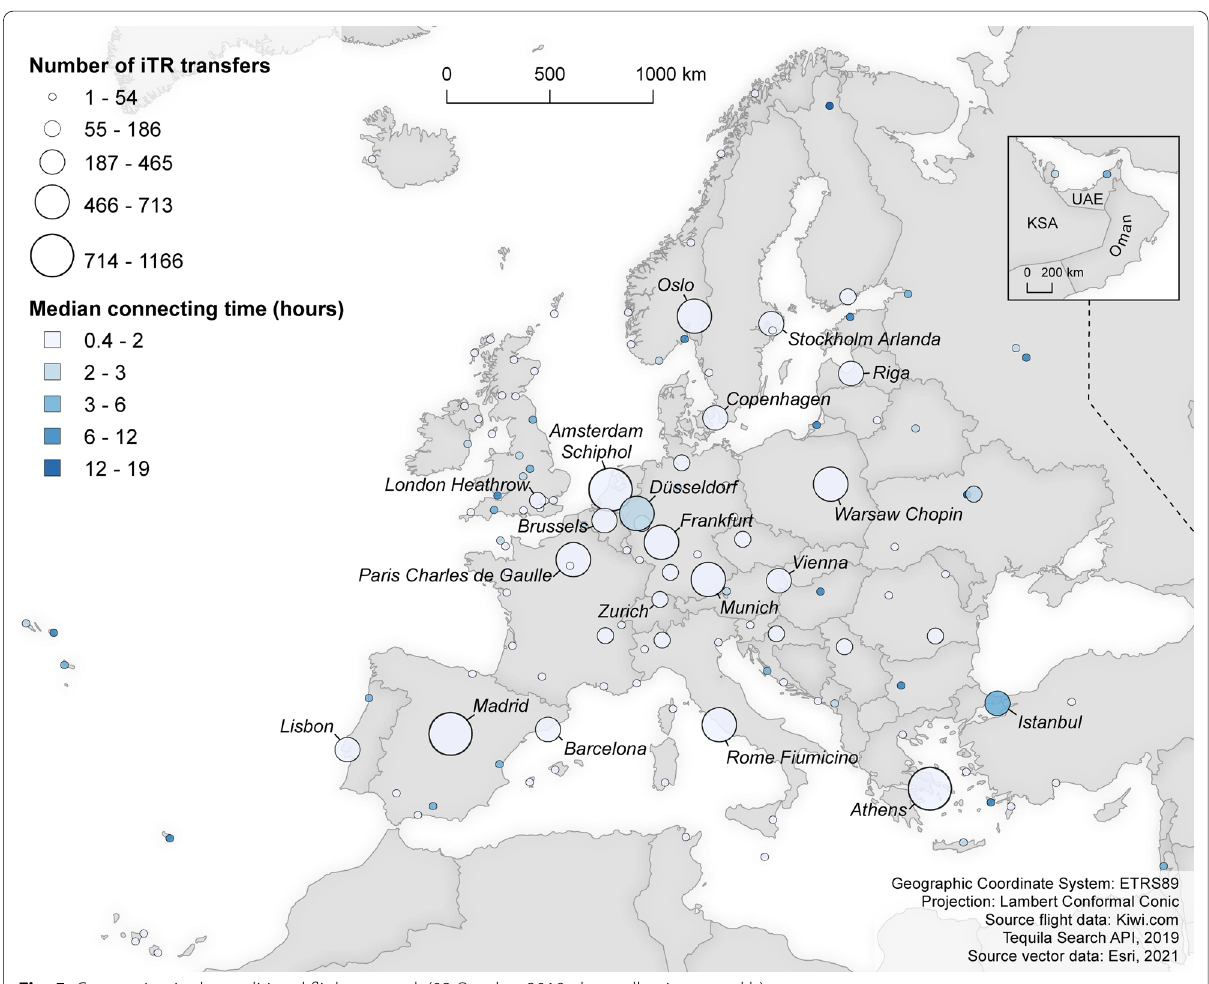
Fig. 5 Connecting in the traditional flight network (02 October 2019, data collection round